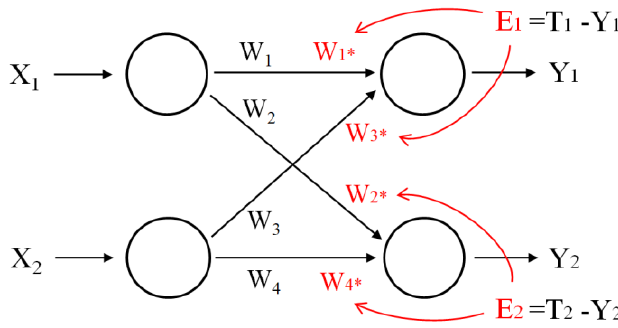
Figure 3. Principle of the back-propagation algorithm.